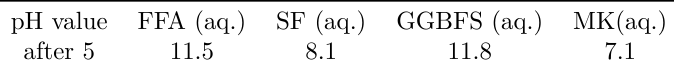
Table 4. pH of aluminosilicate